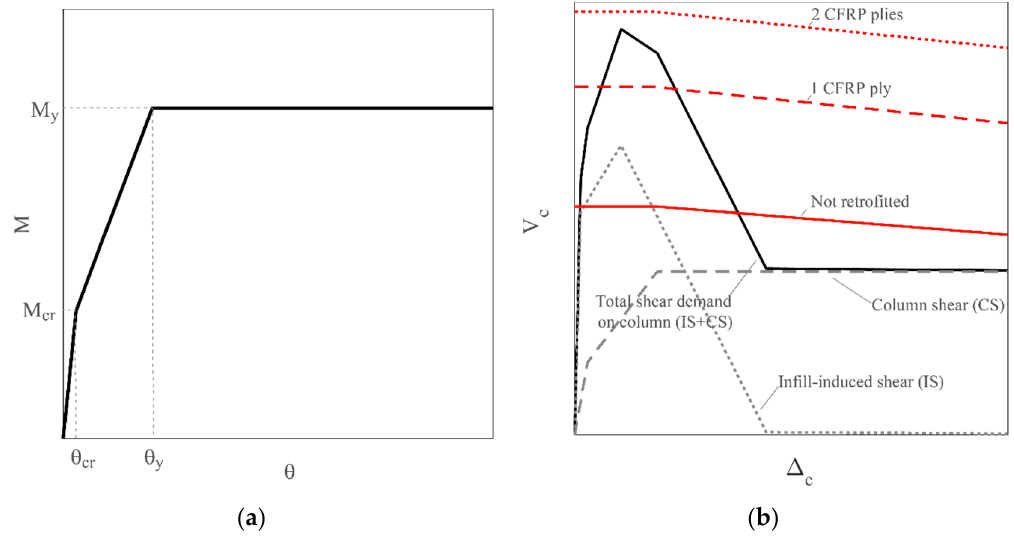
Figure 2. Moment-rotation relationship for RC columns ( a ) and the corresponding V- Δ diagram ( b ). In ( b ) also the additional shear on columns induced by infill panels is shown, along with the adopted shear capacity model for not retrofitted building and for different retrofit options.